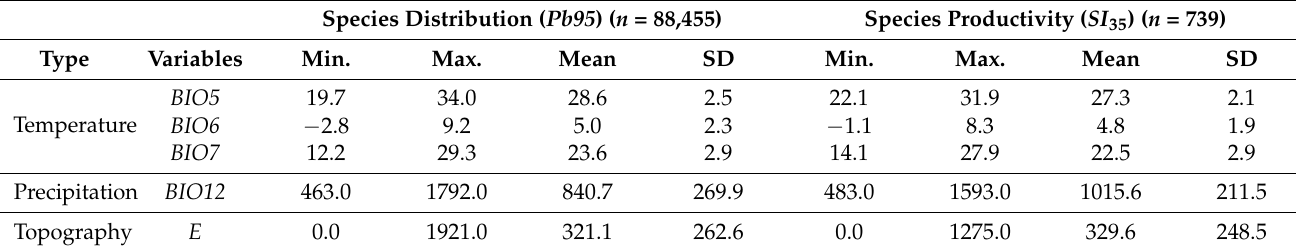
Table 2. Selected ML models (ME) for species distribution and productivity. Regressor variables summary